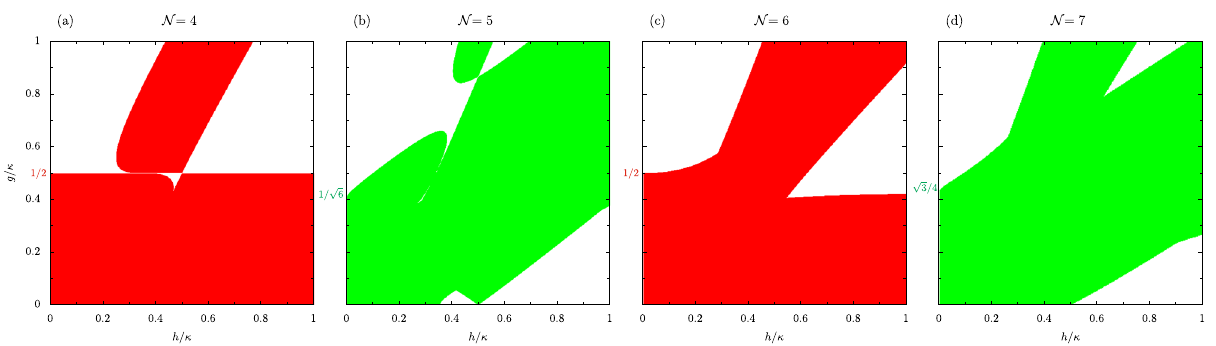
Fig. 7 Phase diagrams of oligomer chains with long-range interactions. a – d PT symmetry phase diagrams of oligomer chains of size N ¼ f 4 ; 5 ; 6 ; 7 g , given by the evolution of the exceptional point ð g = κ Þ N , as a function of the fi rst and second-neighbor couplings g and h , both in units of κ . White: unbroken phase. Colors: broken phase. The analytic results in the h → 0 limit are marked on the vertical axis [Eq. (29)]. The N ¼ 3 case was already presented in Fig.